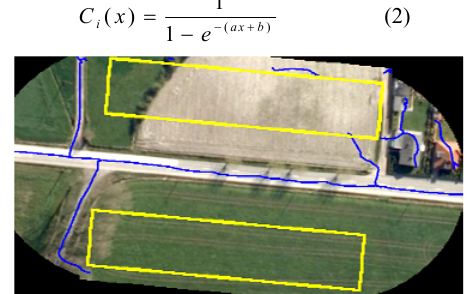
Figure 1: 2D line extraction result (blue) and region mask (yellow) for computing entropy E 3D_line: This module is based on (Hinz and Baumgartner, 2003), where roads are detected as “valleys” in the nDSM.